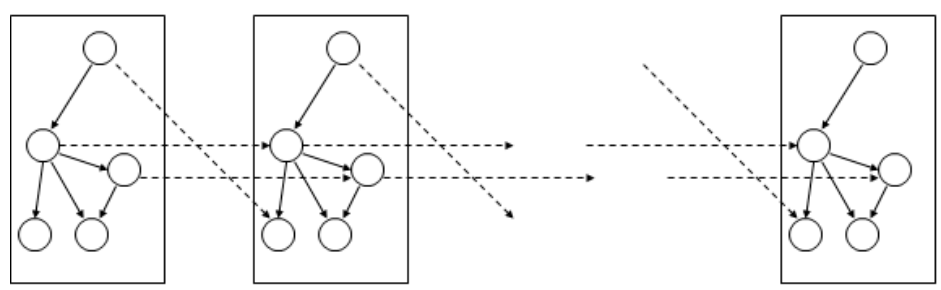
Figure 17. SD model at three different time instances showing variable dependencies.